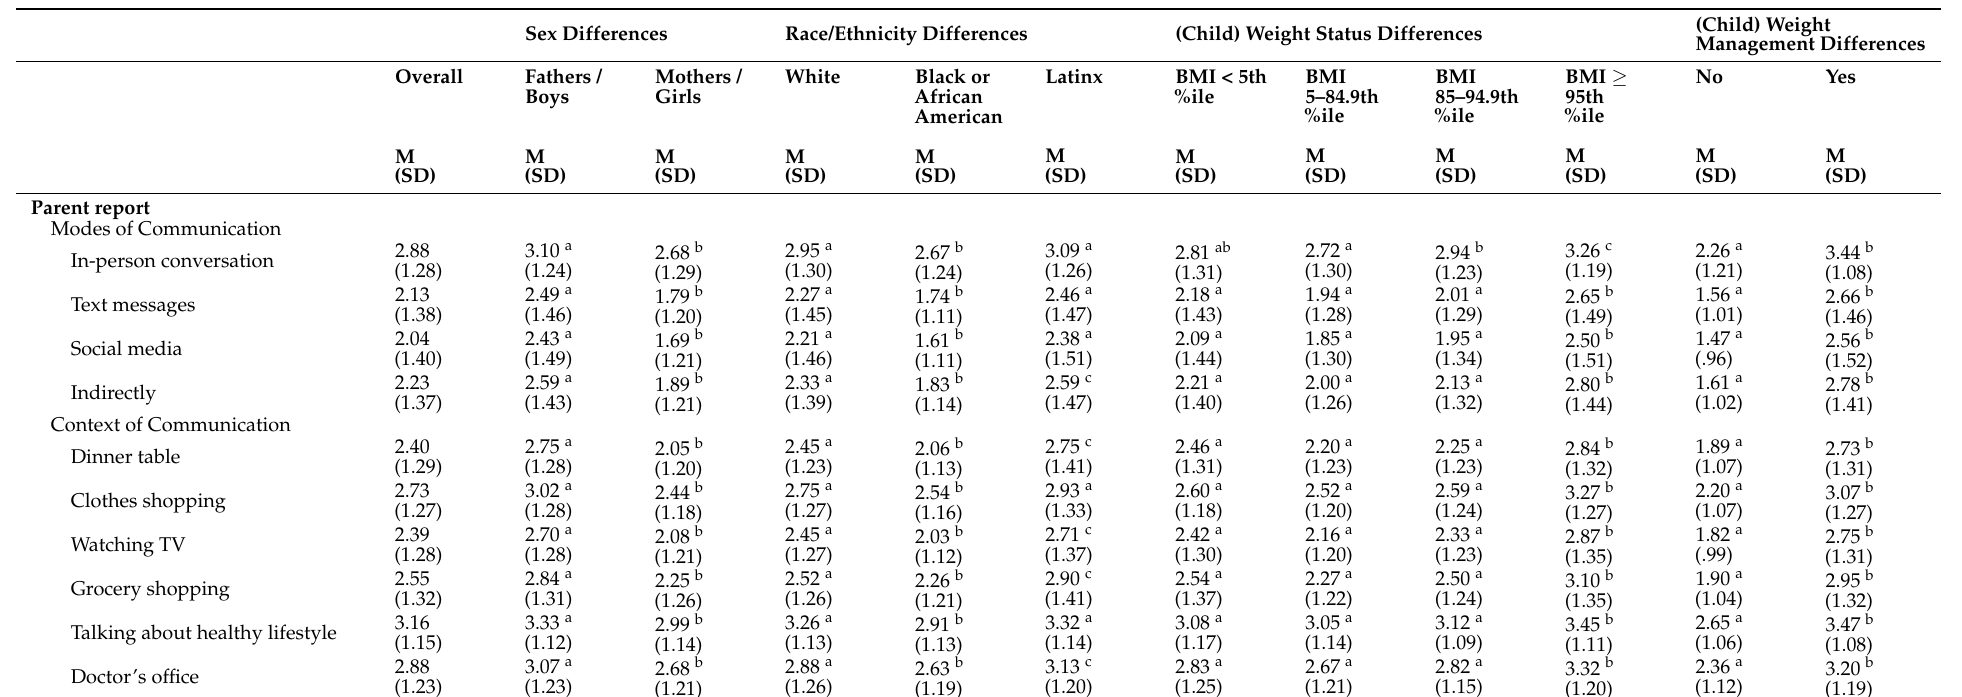
Table 9. Demographic and weight-related differences in frequency of parental weight communication across modes and contexts. Sex